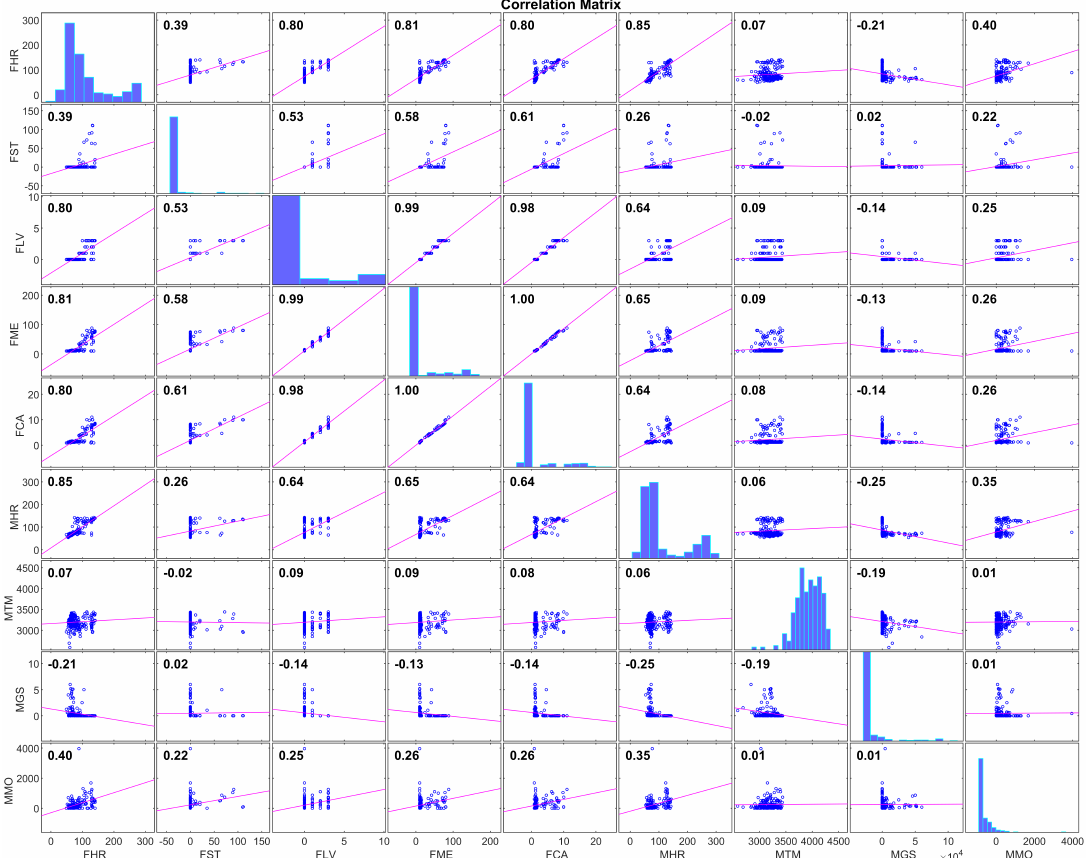
Figure 1. Correlation matrix of the wearable signals from the subset of valid variables selected. Note that the quantization of some of the variables renders point density in some of the subfigures very different from others. For example, most of FST values are located around zero, which makes linear regression plots look like the line does not fit the data, but this is not the